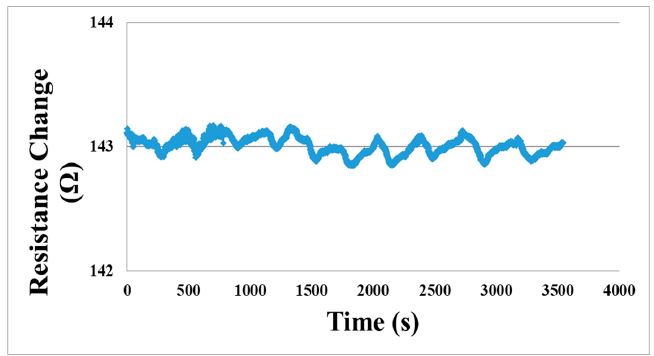
Figure 9. Real ‐ time detection of hydrogen inside proton battery. Figure 9. Real-time detection of hydrogen inside proton